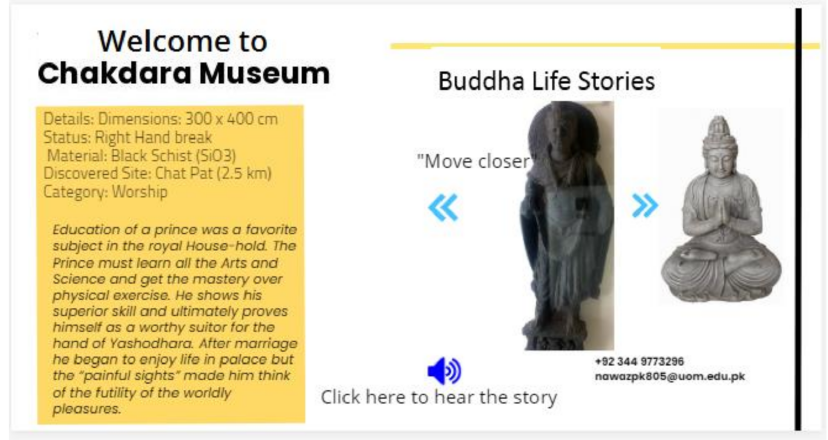
Figure 14. Screen image of the information displayed on the screen.